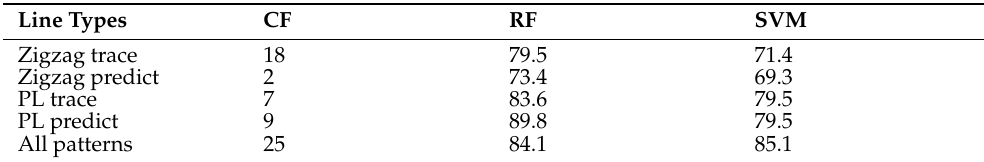
Table 10. Classification accuracy (in %) of RF and SVM for common features of handwritten pat- tern dataset.